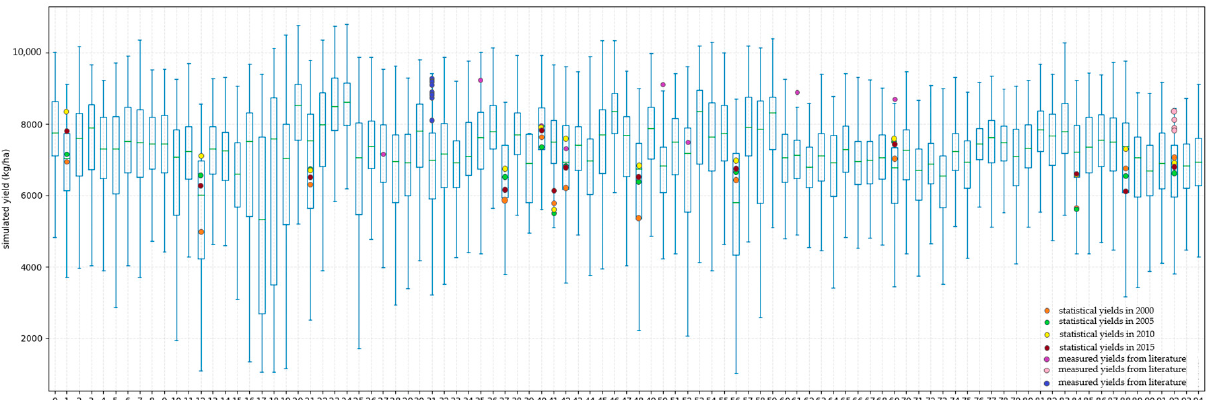
Figure 5. Box Plot of Simulated Yields. There are a total of 95 observation stations in the study area, and each observation station has simulated the corn yield under various growth scenarios. The measured and statistical yields of some observation stations are marked in the figure. The measured yield data is from relevant references [22,46,47].